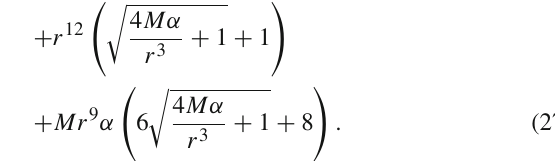
= 1 . 14419 − 0 . 549234 i , M = 1 / 1